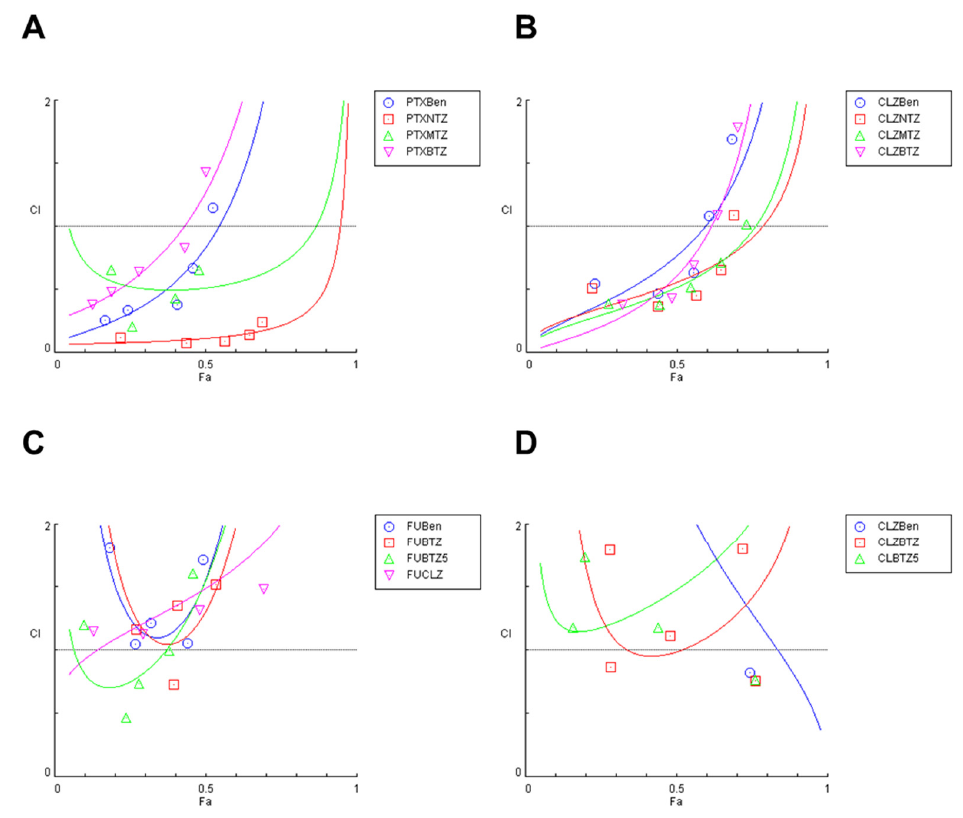
Figure 12. Chou–Talalay method Fa–CI plot of ( A ) PTX and ( B ) CLZ combined with CPP2–thiazole conjugates in PC-3 cells and of ( C ) 5-FU and ( D ) CLZ combined with CPP2–thiazole conjugates in HT-29 cells. CI is plotted on the y -axis as a